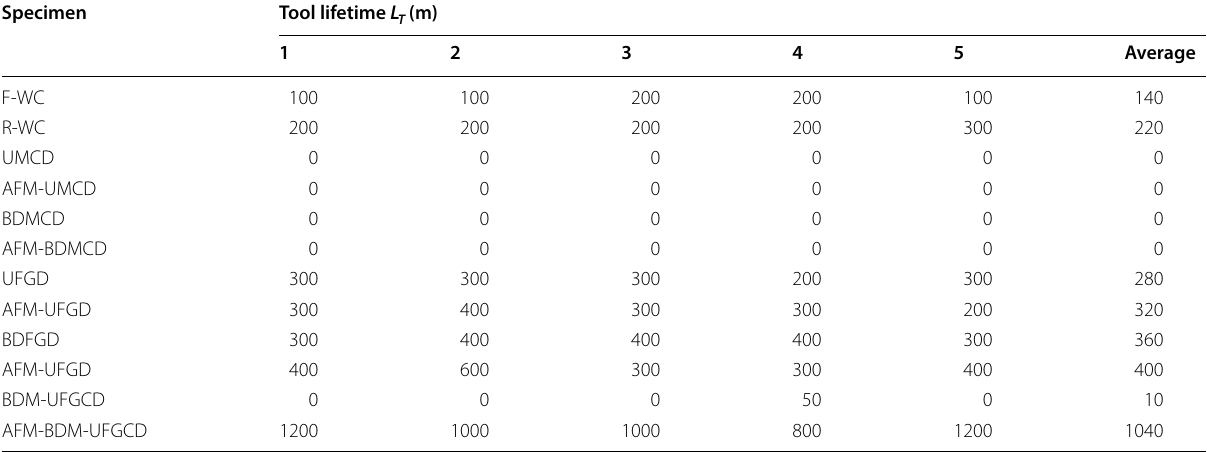
Table 4 Tool lifetimes of different specimens